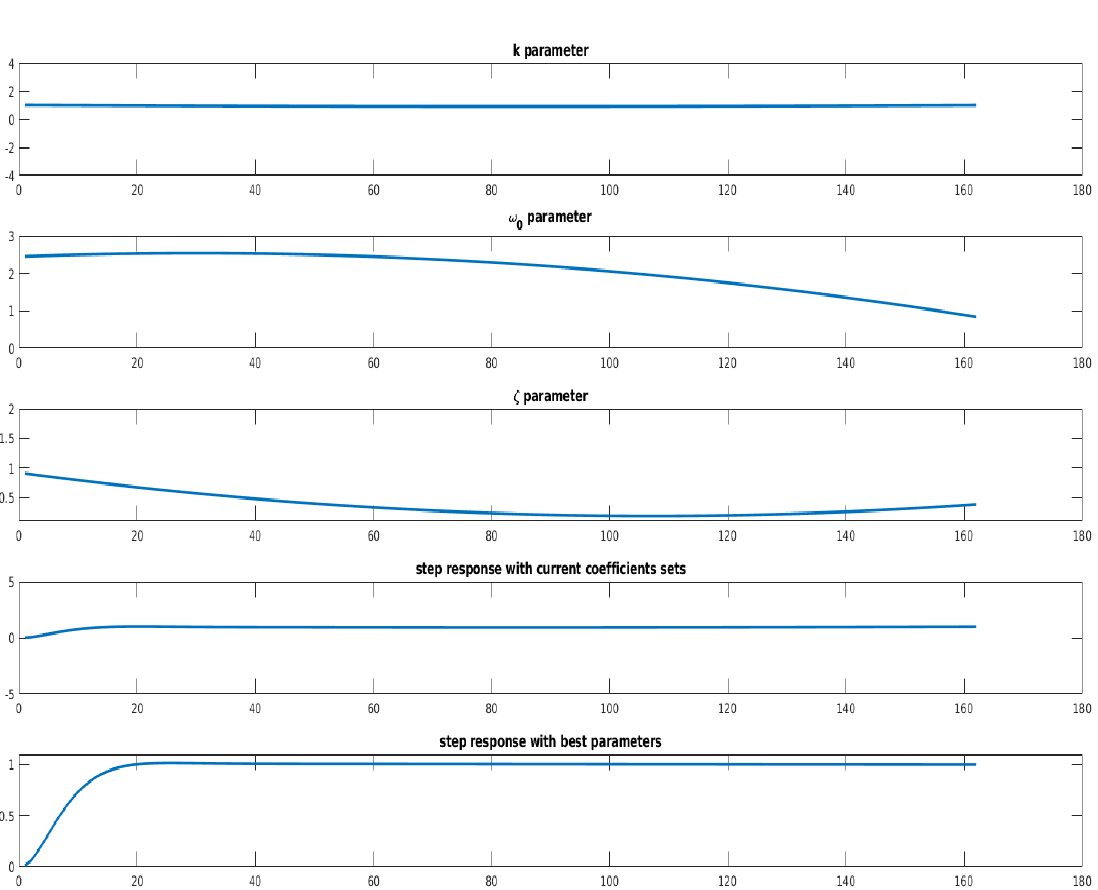
Figure 7. Second stage of the optimization routine. The base filter is the digital oscillatory system with ζ =3.83 · 10 − 1 , ω 0 = 8.41 · 10 − 1 , k = 1, and t s = 1/10